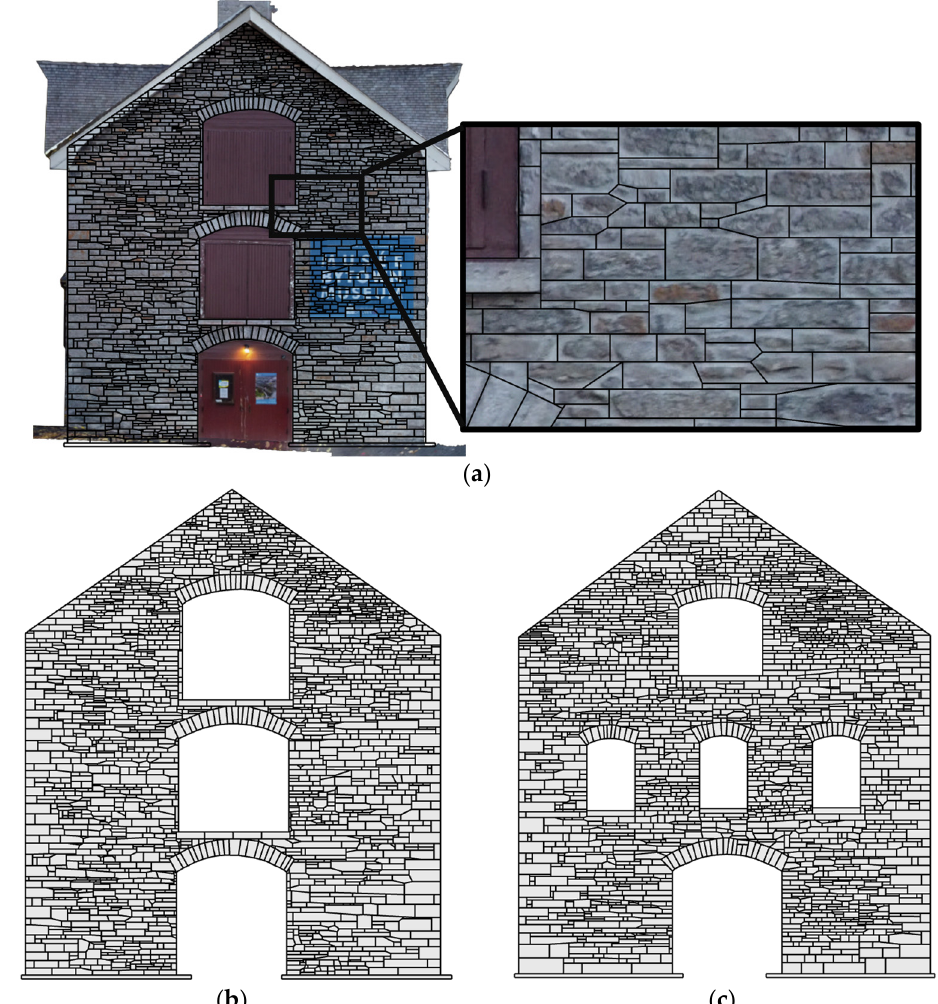
Figure 8. ( a ) Detailed view of South Façade traced in Rhino6, ( b ) South and ( c ) North